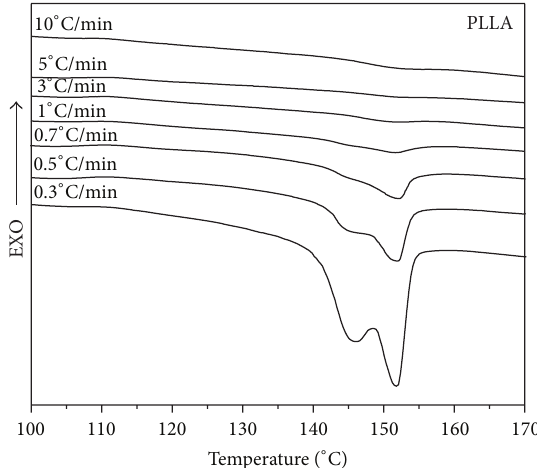
Figure8:MeltingbehaviorofPLLAatheatingrateof10 ∘ C/minafter nonisothermal crystallization with different cooling